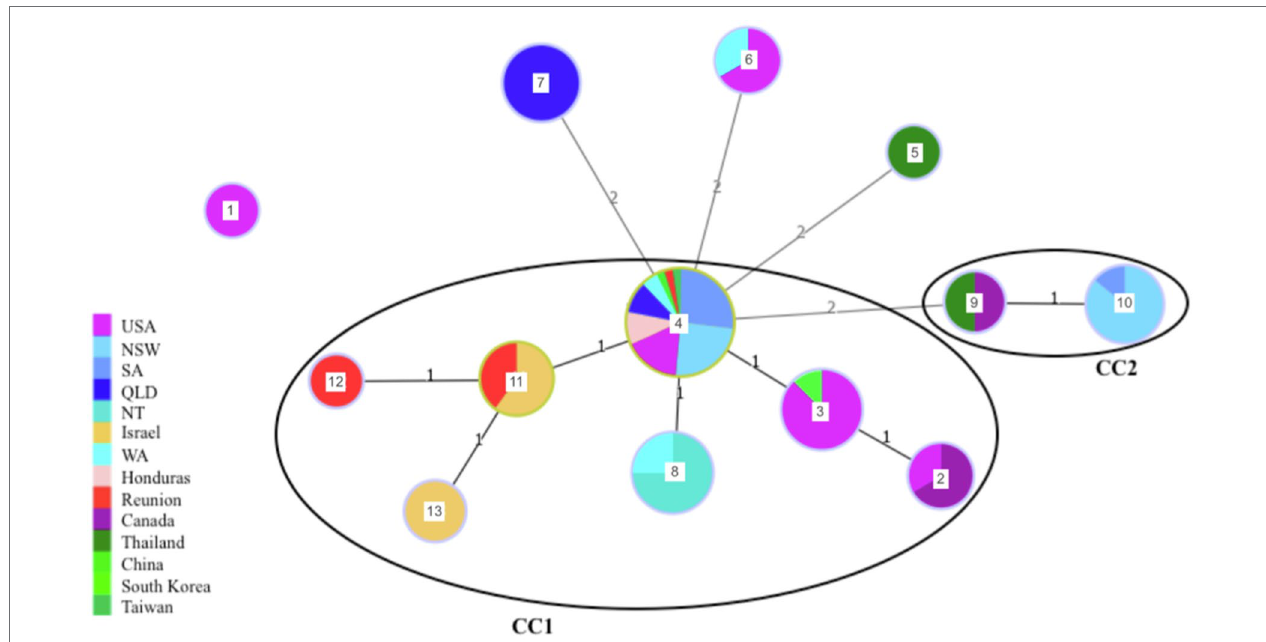
FIGURE 2 | Minimum spanning tree of S. iniae collection illustrating the evolutionary relationships between isolates depending on their geographical origin. Each circle represents a ST and the size of the circle is proportional to the number of isolates within this ST (log scale). ST number is indicated at the center of each circle. Numbers over the connecting lines indicate the number of locus difference between the closest STs (1: SLV; 2: DLV). Clonal complexes are shown (7 of eight alleles